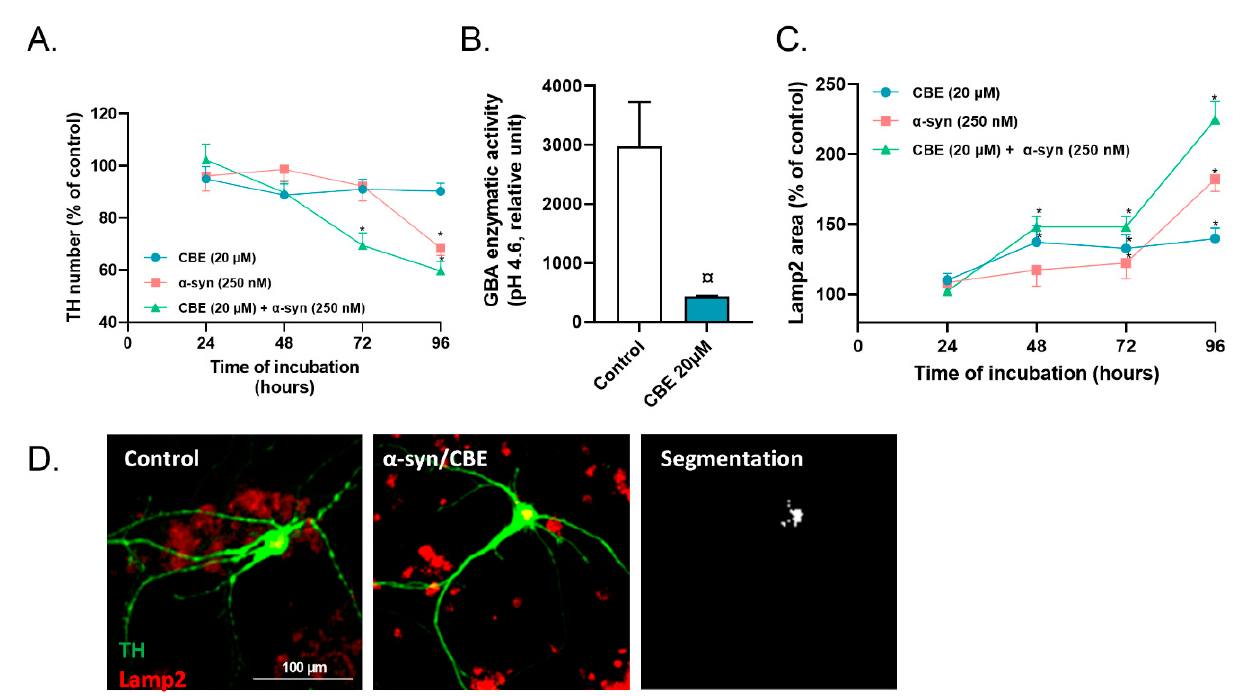
Figure 3. Progressive loss of TH(+) neurons after application of α -syn or α -syn + CBE. ( A ) Number of TH(+) neurons (control = 23 ± 5) after different incubation times with CBE and α -syn, ( B ) enzymatic GBA activity following CBE intoxication and ( C ) lysosomal impairments (control = 46 ± 3) after different incubation times. ( D ) Representative pictures of Lamp2 staining (red) in TH neurons (green) and the computer-assisted segmentation resulting from data processing (white): control condition (left panel), α -syn condition (middle panel) and segmentation (right panel). All values are expressed as mean ± SEM; *, p < 0.05 with One-way ANOVA followed by Fisher’s LSD test; or ¤ p < 0.05 with Mann-Whitney